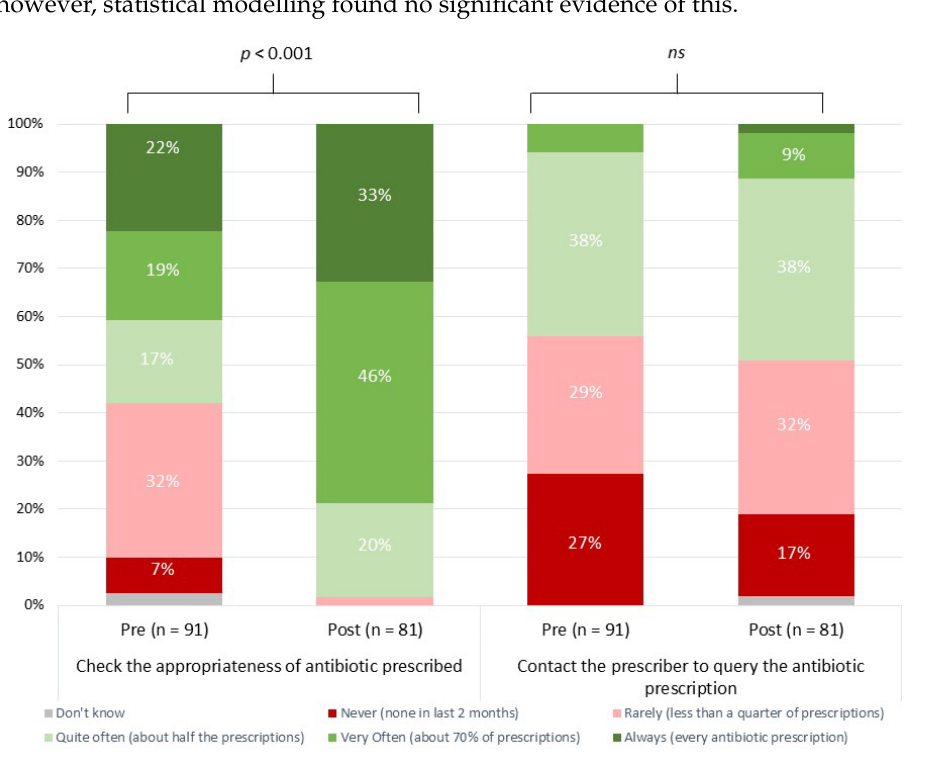
Figure 3. Community pharmacy staff reported checking of antibiotic appropriateness and contacting the prescriber to query the prescription, pre- and post-intervention. P signifies the strength of evidence from the statistical modelling for an improvement in the reported behaviour at post-intervention. Ns signifies there is no evidence of a significant improvement in behaviour at post-intervention.